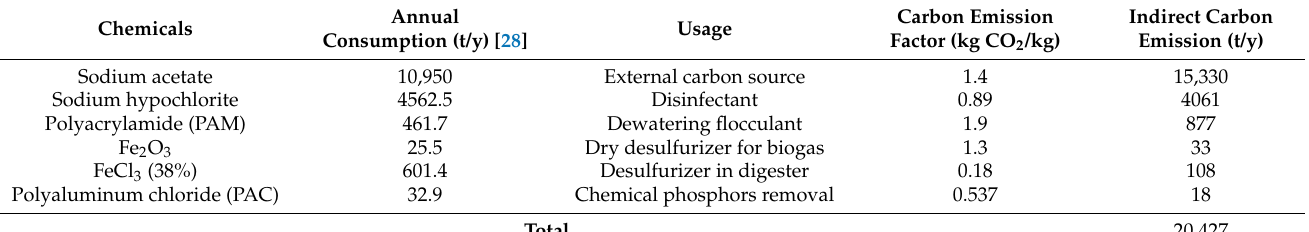
Table 6. Chemical consumption and its indirect carbon